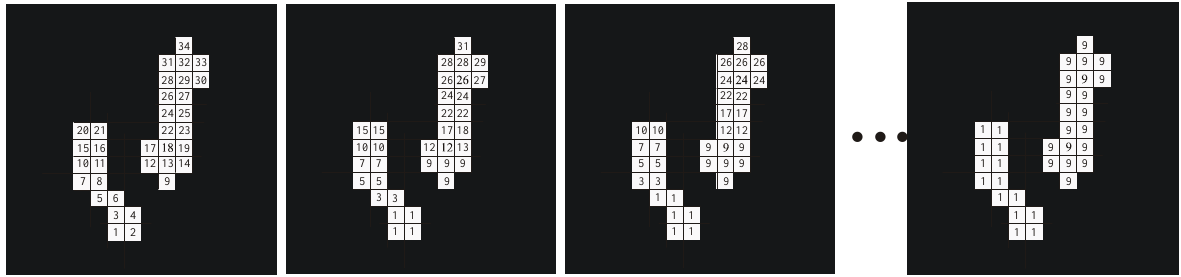
Figure 5. Schematic illumination of the image identification